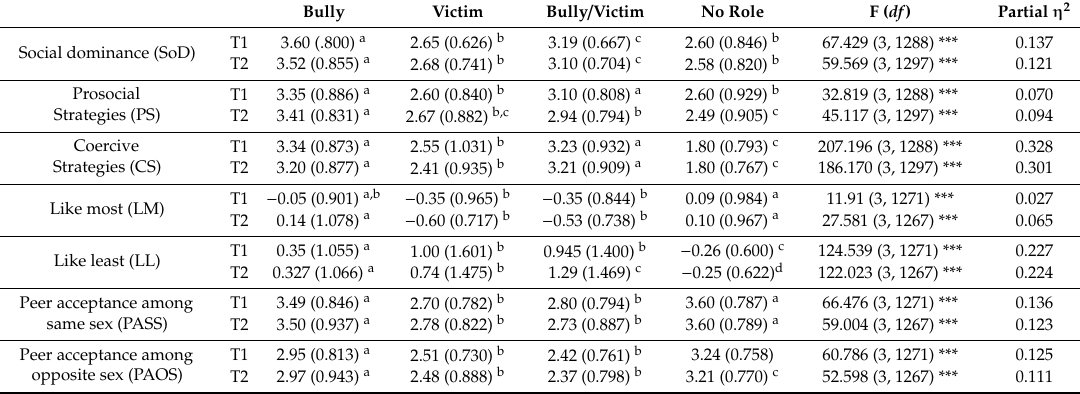
Table 4. Means (standard deviations) of SoD, PS, CS, LM, LL, PASS, and PAOS by bullying